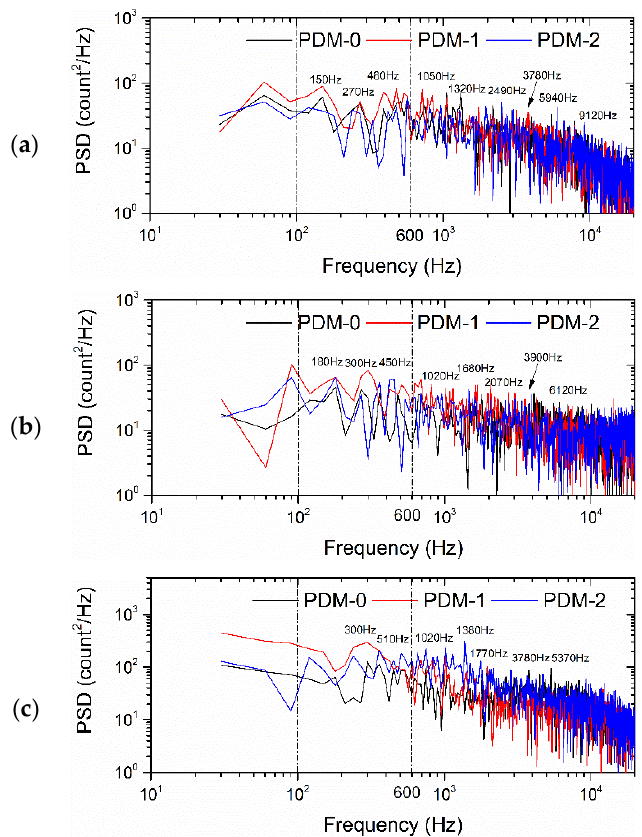
Figure 7. Power spectrum density of FFT for PDM coefficients. ( a ) φ = 0 .1, ( b ) φ = 0 .15, ( c ) φ = 0 .2.